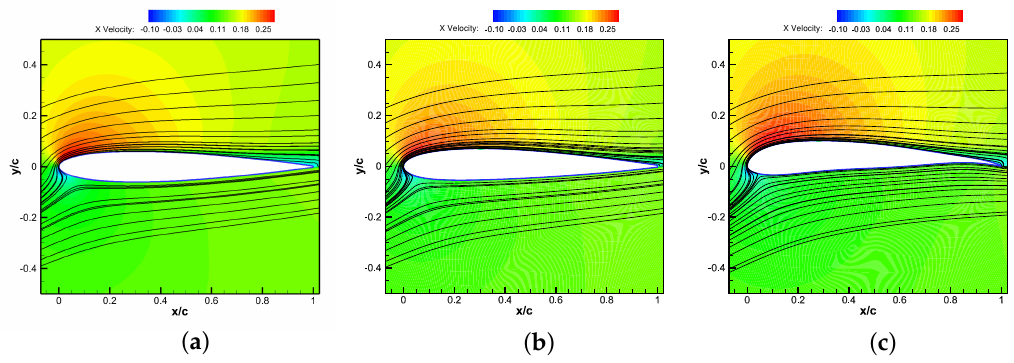
Figure 7. The streamline of the airfoils at α = 16deg. The contour is colored with streamwise velocity: ( a ) baseline; ( b ) CST; and ( c ) Grassmannian.